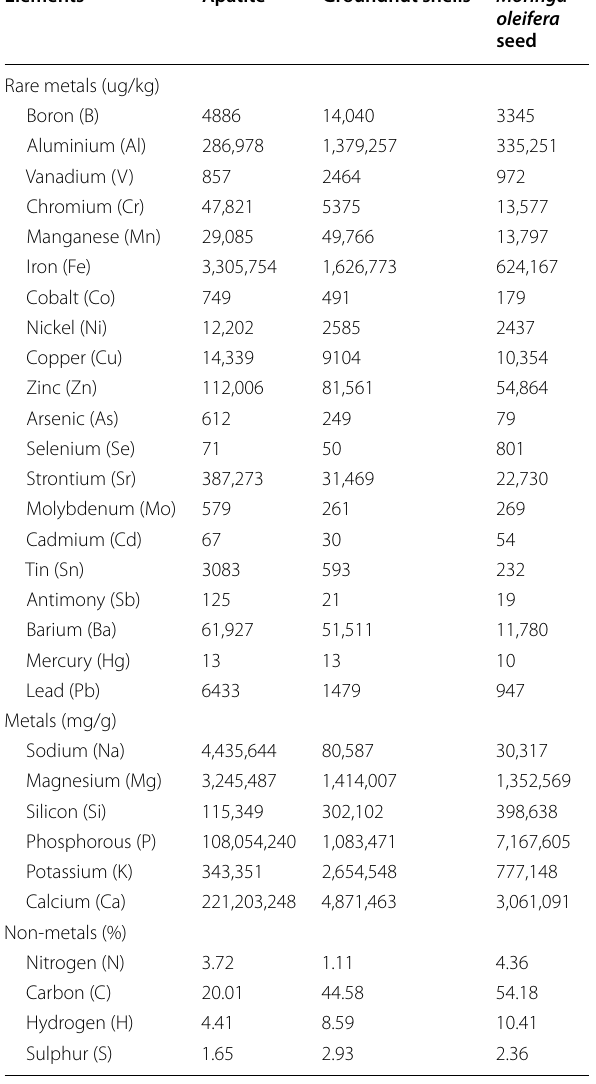
Table 4 Concentration of PAHs concentration in coal tar at room